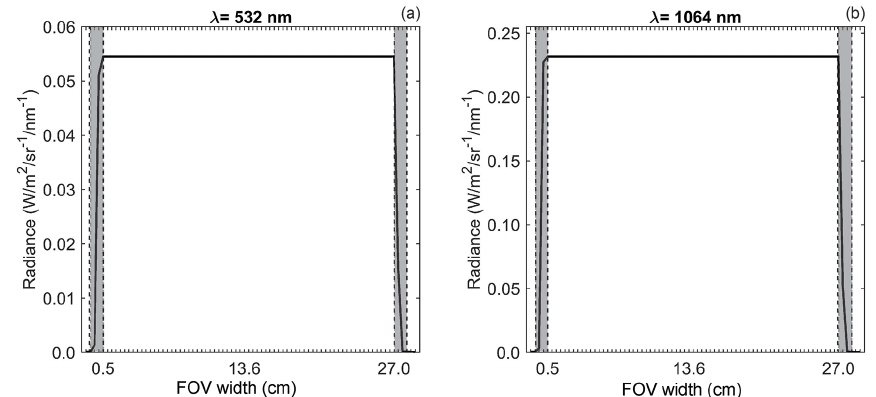
Figure 4. Laboratory characterization of the nadir-viewing 1 ◦ foreoptic lens point spread function and IFOV using the NIST-traceable-source output. Results from green (a) and NIR (b) wavelengths at which SIMPL operates were used to summarize in-IFOV (thick black line within the dotted line boundaries) and near-IFOV widths (grey regions within the dotted lines).